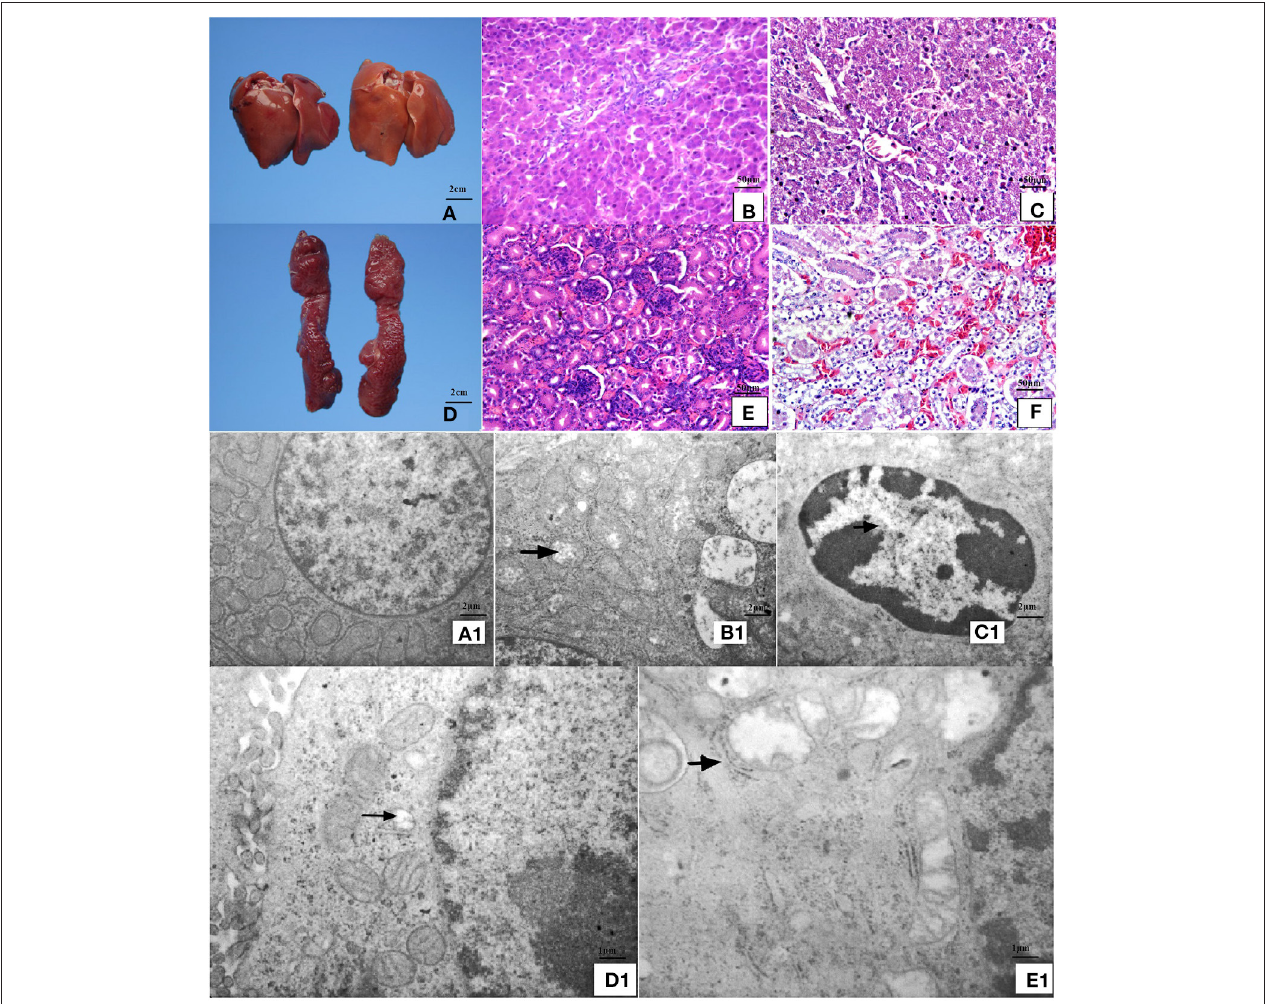
FIGURE 1 | Anatomical, histopathological, and ultrastructural observations of liver and kidney. (A) The liver was swollen, blunt-edged, and yellow and (D) the kidney was swollen in the MD group (right side of panels) at 42 days of age compared to the control group (left side of panels). (C) Severe granular degeneration in liver cells was observed in the MD group at 42 days of age (H&E staining × 400) compared to (B) the control group (H&E staining × 400). (F) Vacuolar degeneration was observed in kidney cells with lots of liquid entry into the cytoplasm in the MD group at 42 days of age (H&E staining × 400) compared to (E) the control group (H&E staining × 400). (A1) Hepatocytes in the control group possessed clear bilayer lipid membranes and normal organelles (TEM × 12,000). (B1) The mitochondria of hepatocytes in the MD group were swollen or vacuolated with degenerating cristae (left arrow) (TEM × 12,000). (C1) The chromatin of hepatocytes in the MD group was condensed (left arrow) (TEM × 25,000). (D1) Renal cells in the control group possessed normal organelles (TEM × 25,000). (E1) The mitochondria of hepatocytes in the MD group were swollen or vacuolated with degenerating cristae (left arrow) (TEM × 25,000). MD, methionine deficiency; H&E, hematoxylin and eosin; TEM, transmission electron